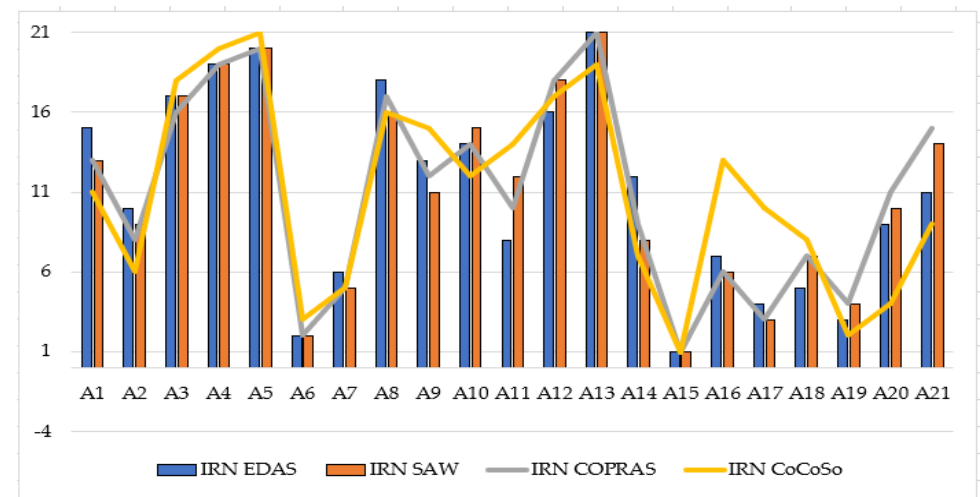
Figure 2. Values of alternatives through a comparative analysis.